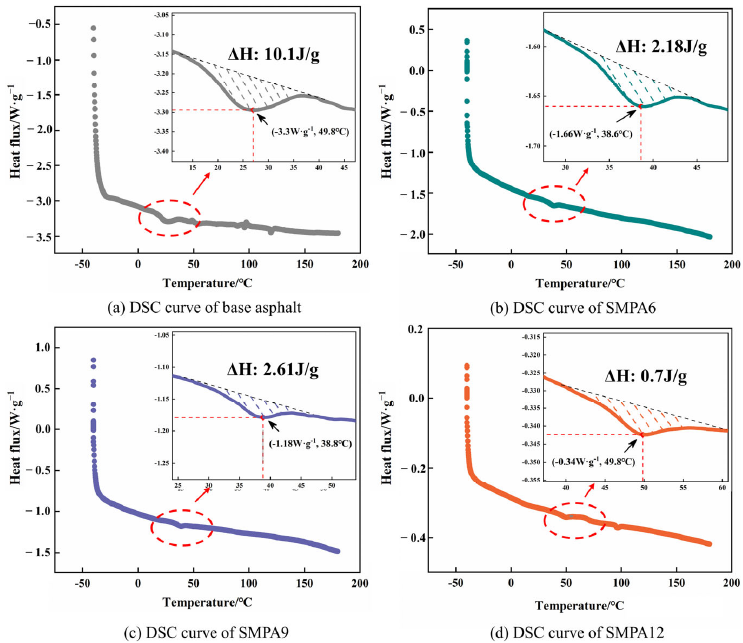
Figure 22. Thermodynamic parameters of asphalt binders.